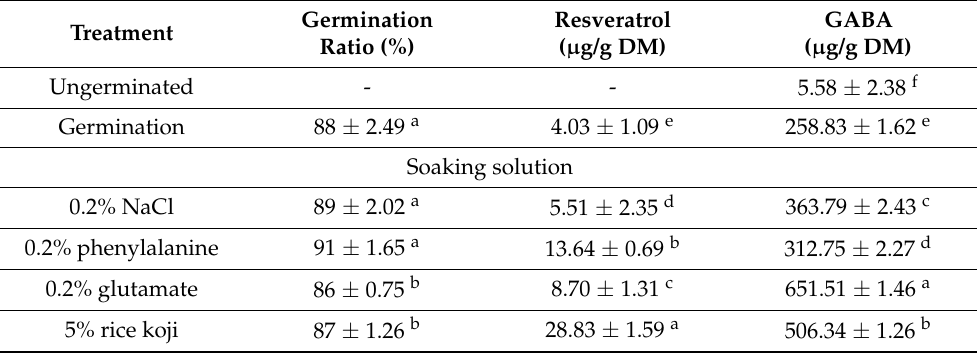
Table 1. Effects of different soaking solutions on germination ratio, resveratrol, and γ -aminobutyric acid content of germinated peanuts.